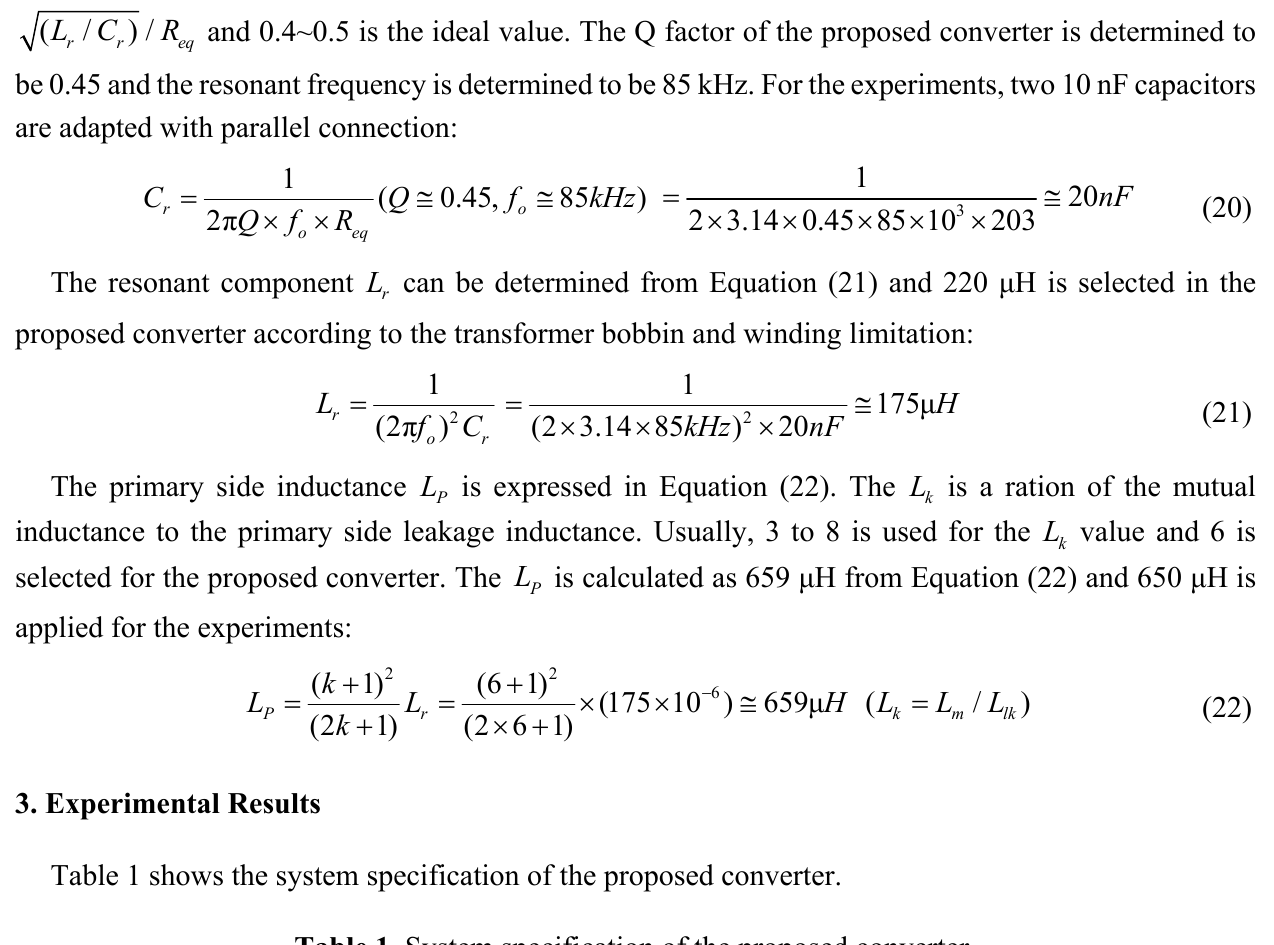
Table 1. System specification of the proposed